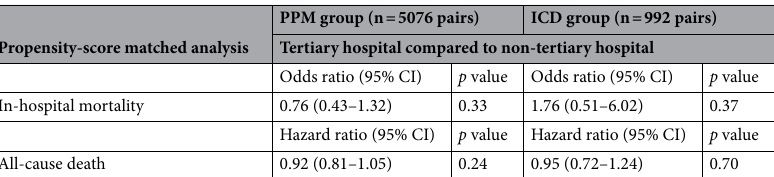
Propensity-score matched